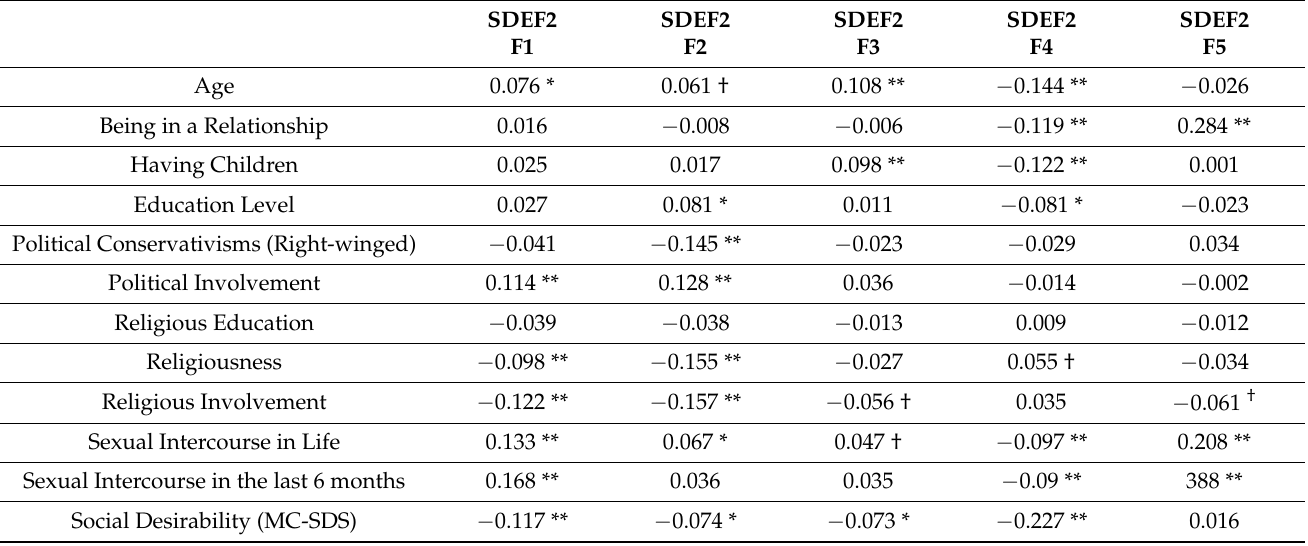
Table 4. Person’s correlation matrix between SDEF2 factors, social desirability (MC-SDS), and sociodemographic variables (n = 1773).